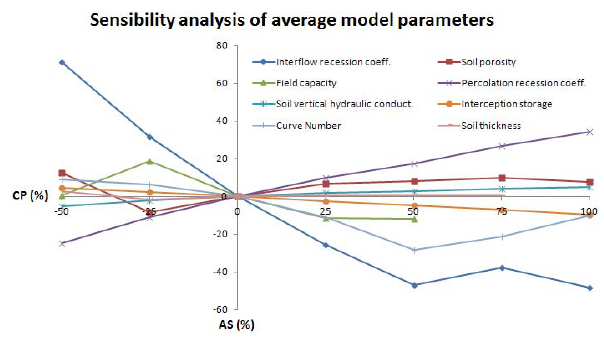
Fig. 10. Sensitivity analysis of model parameters on estimated recharge, average results for the nine pilot basins (only the eight most sensitive parameters are showed). CP is the relative change of a given variable or parameter and AS is the relative change in the recharge